Question: In a single sentence, describe what this figure presents.
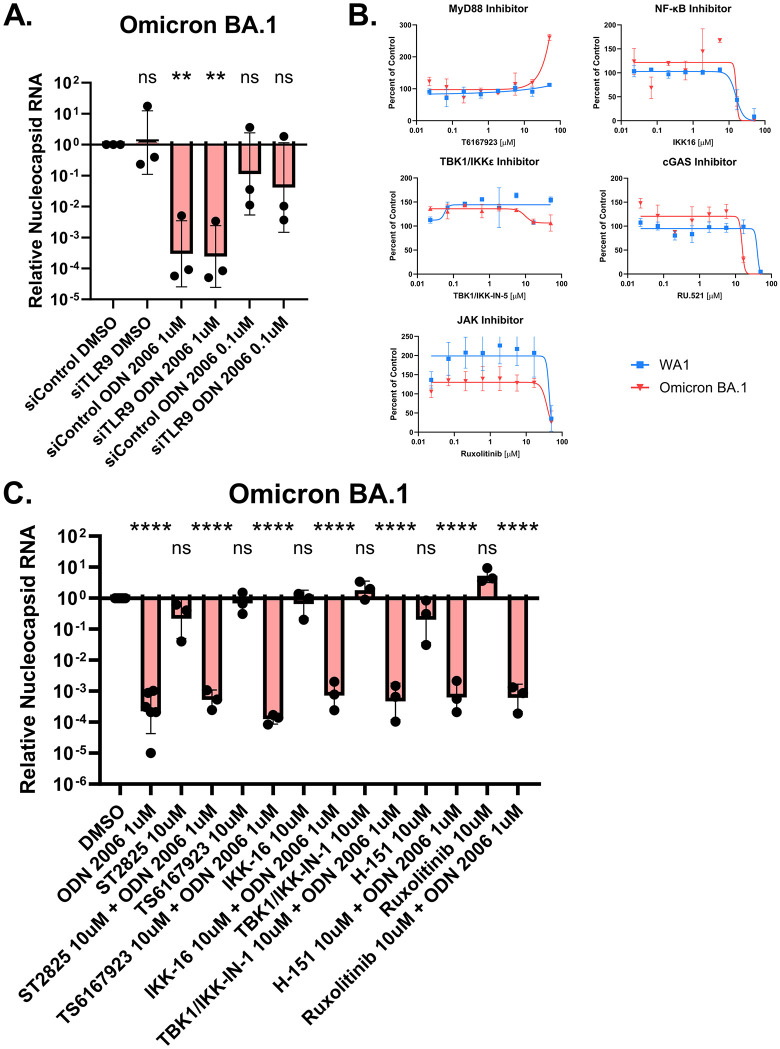
Answer: Oligodeoxynucleotides inhibit Omicron infection independent of TLR9 and canonical innate immune signaling. (A) Calu-3 cells were transfected with control siRNAs or siRNAs targeting TLR9 and at 48h treated with vehicle (DMSO) or ODN2006 as indicated and subsequently infected with SARS-CoV-2 Omicron BA.1 (MOI 0.2) for 48h prior to processing for RT-qPCR analysis of viral RNA (Nucleocapsid). Mean ±SD with individual biological replicates shown. (B) Calu-3 cells were pre-treated with indicated compounds in 8-pt dose-response for 2h and infected with SARS-CoV-2 WA1 (blue) or BA.1 (red) (MOI 0.5) for 48h and processed for automated microscopy and image analysis quantifying total cell numbers and percent infection (dsRNA + /nuclei+) to determine Percent-of-Control (POC) % positive. Each data point represents the mean±SD of n = 3-6 independent biological replicates. (C) Calu-3 cells were pre-treated with vehicle (DMSO) or inhibitors for 2h and infected with SARS-CoV-2 Omicron BA.1 (MOI 0.2) and 48hpi processed for RT-qPCR analysis of viral RNA (Nucleocapsid). Mean ±SD with individual biological replicates shown. Significance was calculated using One Way ANOVA with Dunnett Correction on DMSO control (***p < 0.001, ****p < 0.0001; ns, no significance).